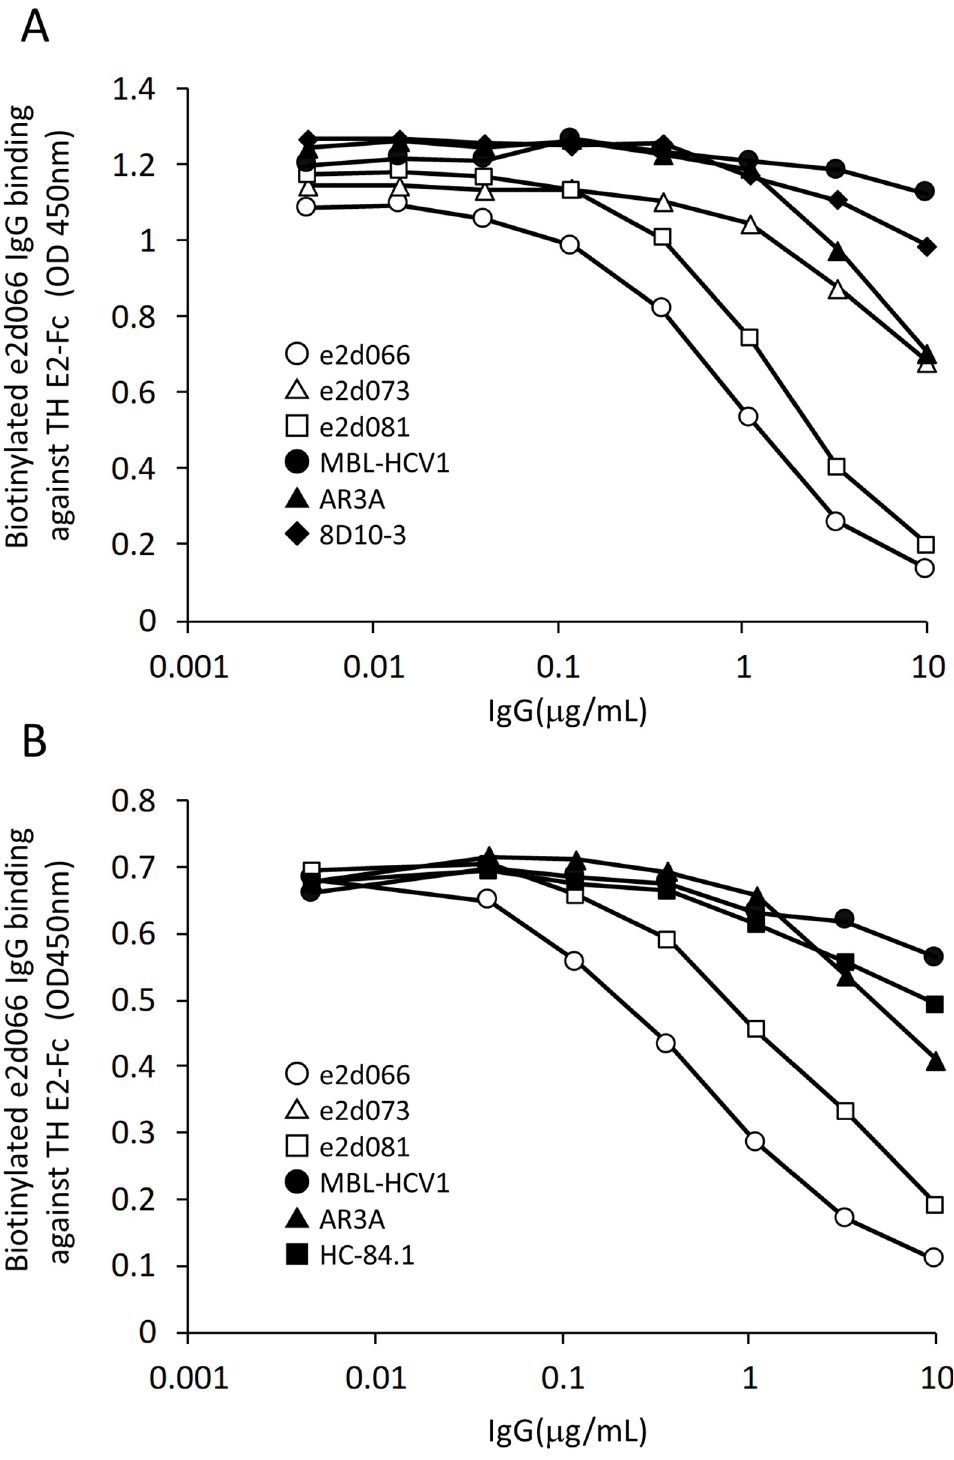
Fig 4. Competition assay using anti-E2 antibodies to compete against e2d066 IgG binding. The TH E2-Fc recombinant E2 protein was used to coat Nunc-Immuno plates (Thermo Fisher Scientific). Biotinylated e2d066 IgG was mixed with each of the other anti-E2 antibodies, and the resulting mixtures were distributed to the prepared plates. Avidin-HRP (GE Healthcare) was used to detect the biotinylated IgGs. The titers of antibodies were measured using a peroxidase assay kit for ELISA (Sumitomo Bakelite Co., Ltd.). (A) Competition with linear epitope antibodies